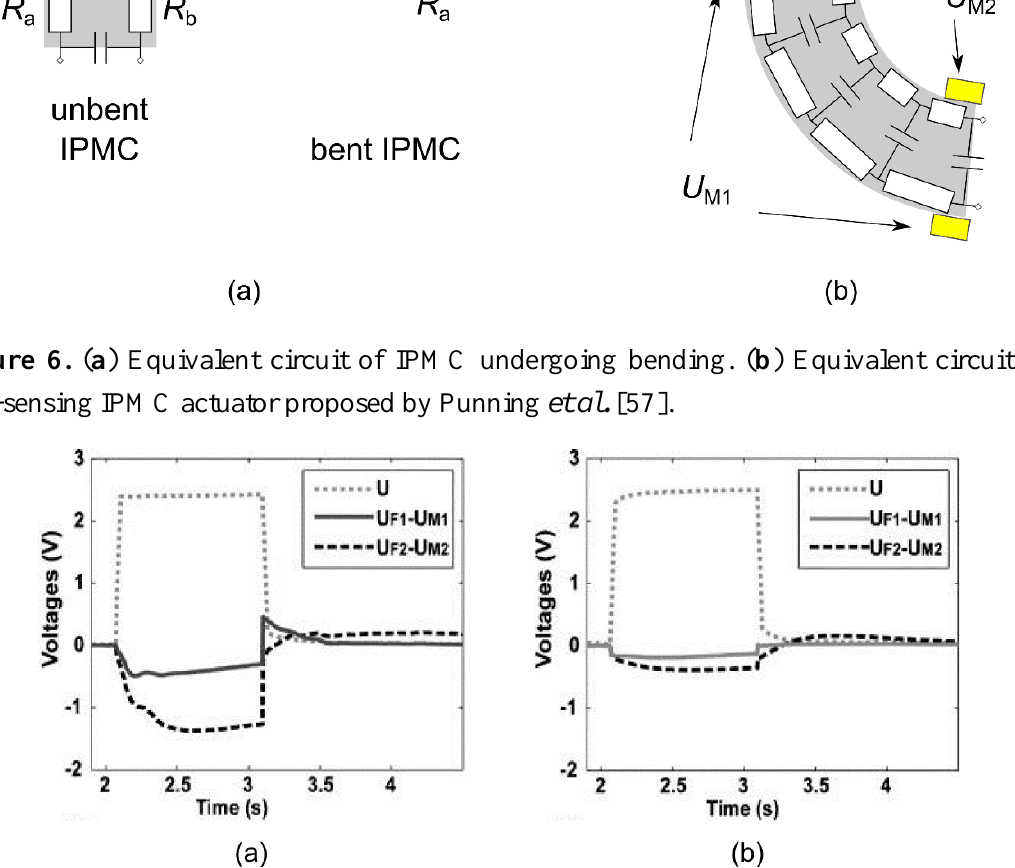
Figure 7. ( a ) Difference of voltage drops when the self-sensing actuator is bending to the left by input voltage. ( b ) The driving voltage of the self-sensing actuator causes bending to the left, but the actuator is obstructed by an external force. U denotes the driving signal and U F1 , U F2 , U M1 , U M2 are explained in Figure 6b. Reprinted from [57], Copyright 2007, with permission from